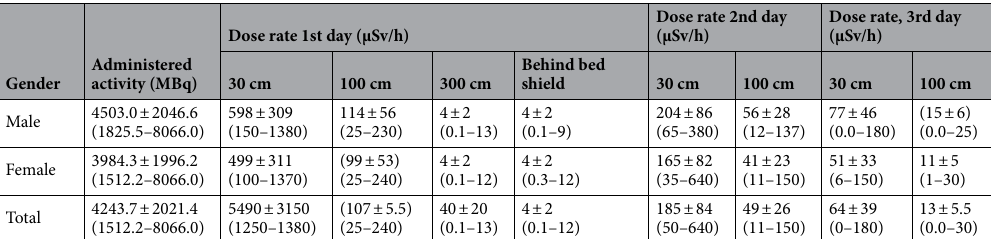
Table 3. Mean, ± Sd and range of patient demographic data in thyroid cancer by using Iodine-131.